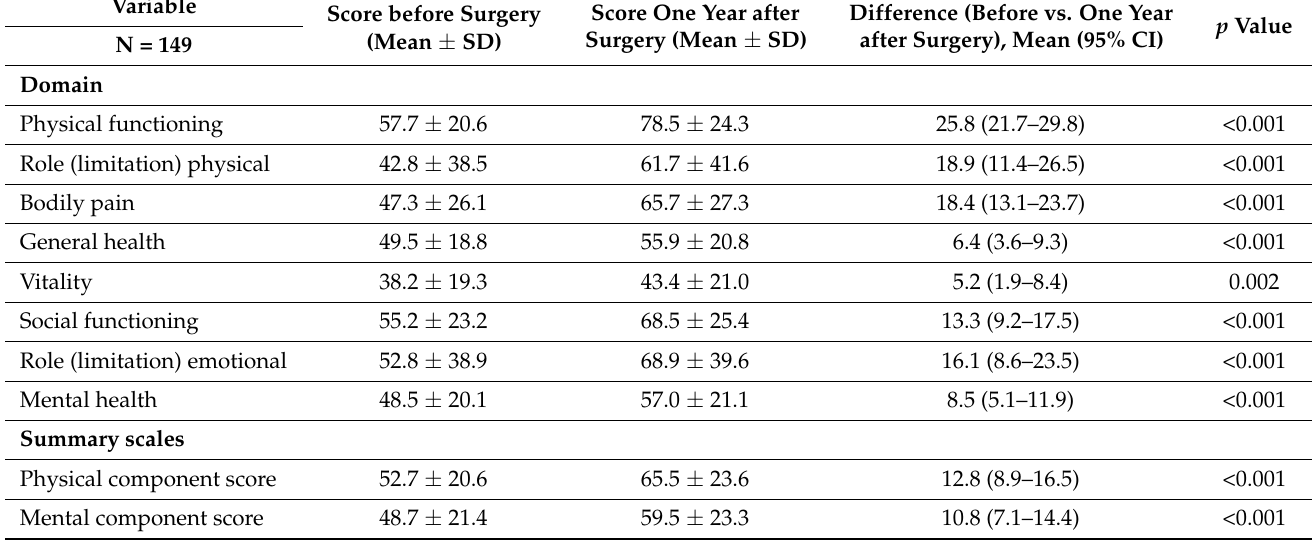
Table 7. Patients with worsened KESS score, but with better QoL one year after